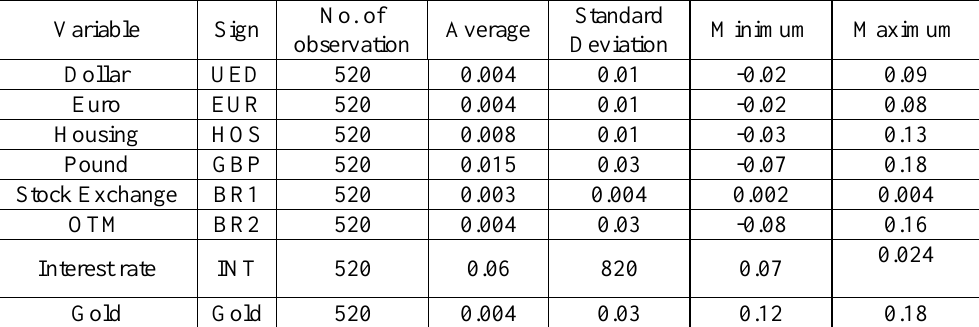
Table 1. descriptive and broadly-applicable